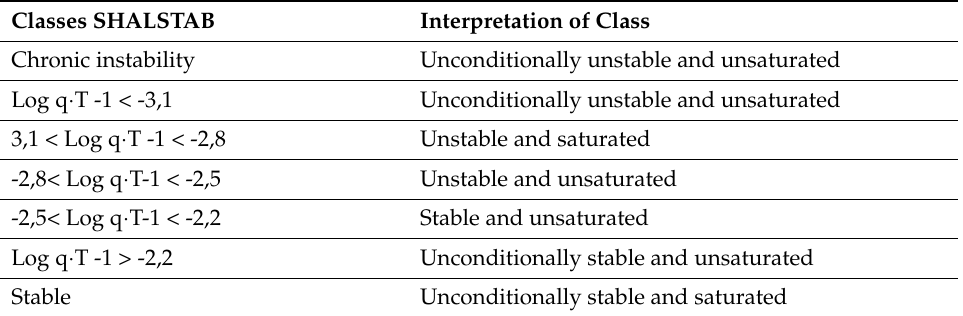
Table 1. Stability classes defined by SHALSTAB and modified from Montgomery and Dietrich [15]. Classes